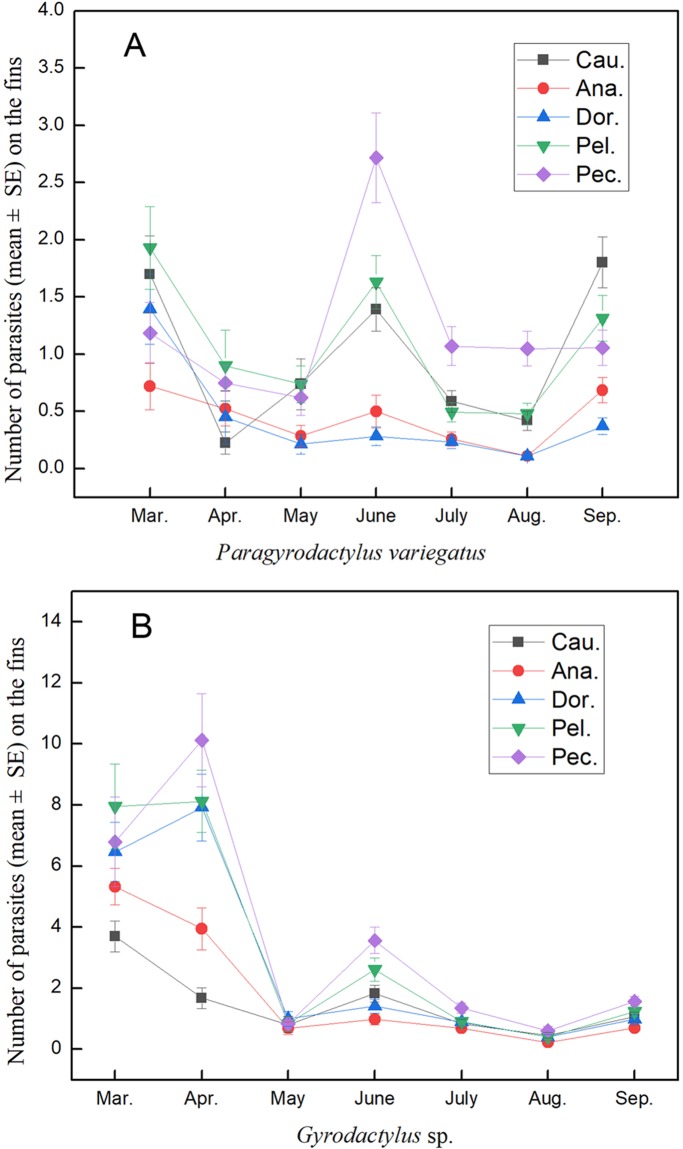
Parasites number (mean±SE) on different fish fins monthly.A. Paragyrodactylus variegatus, B. Gyrodactylus sp.; the abbreviations Ana., Cau., Dor., Pec., and Pel., indicate, anal fin, caudal fin, dorsal fin, pectoral fin and pelvic fin, respectively.